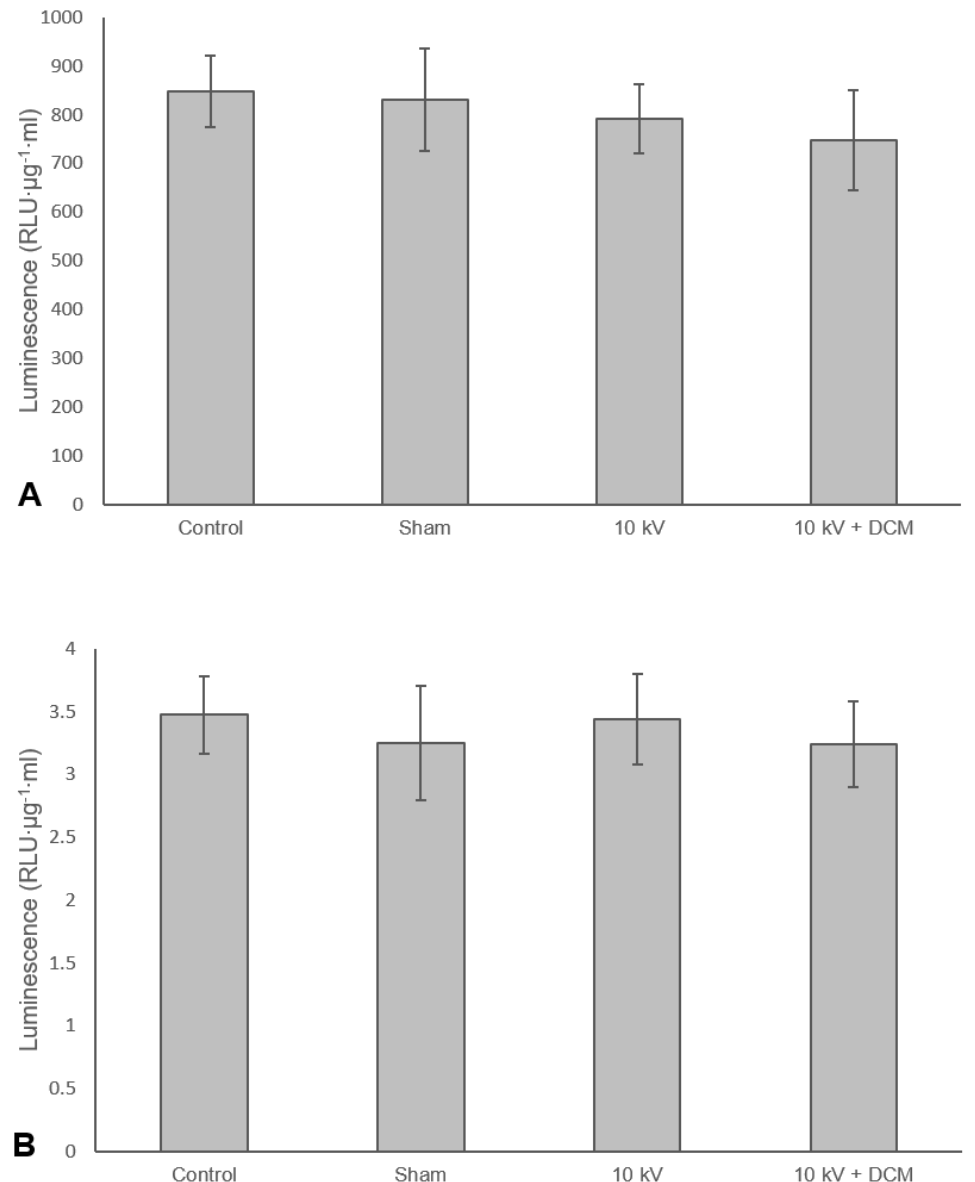
Figure 5. Luminescence, represented as relative light units adjusted for protein concentration, measured after lysis of cells incubated with either MVA ( A ) or Ad ( B ) after single or coaxial electrospray. Working distance: 7.25 cm, Virus solution flow rate: 5 µ L / min, dichloromethane (DCM) flow rate: 25 uL / min. One-way ANOVA and Tukey’s post-hoc tests were used to make statistical comparisons. A p -value of less than 0.05 was considered statistically significant. Error bars represent the standard deviation, n = 3.